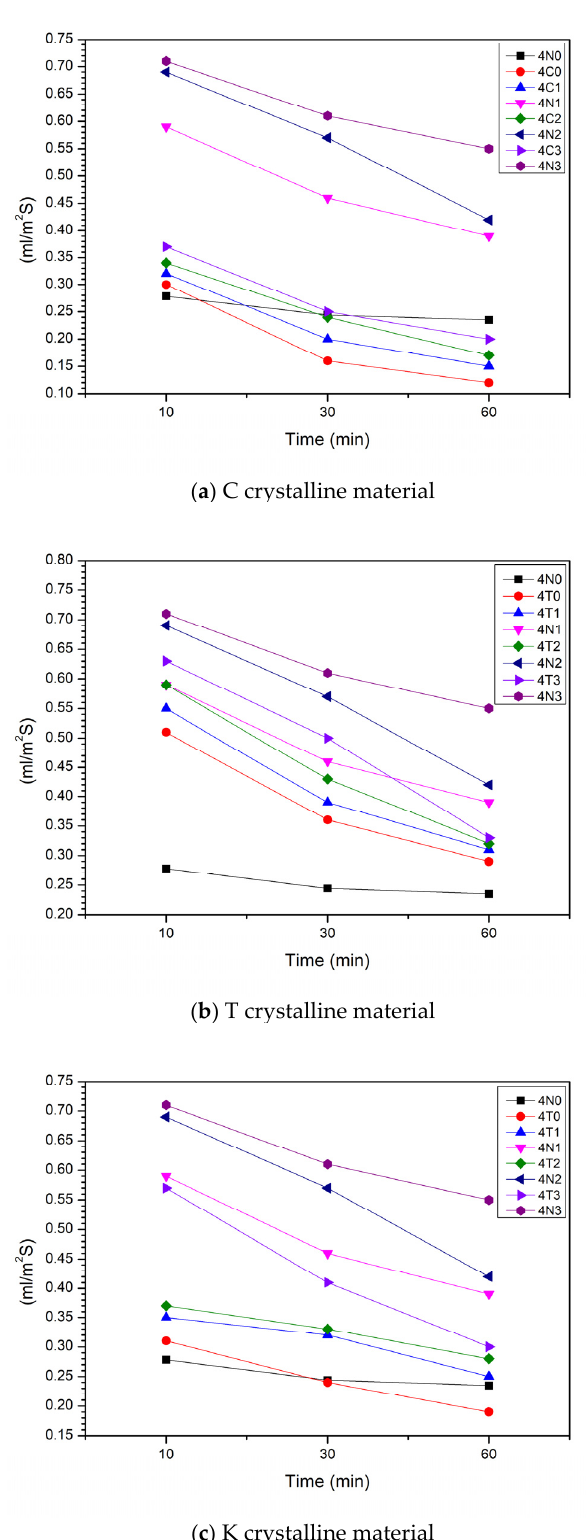
Figure 6. Initial surface water absorption of cement mortar after 7 days when W/C = 0.4.